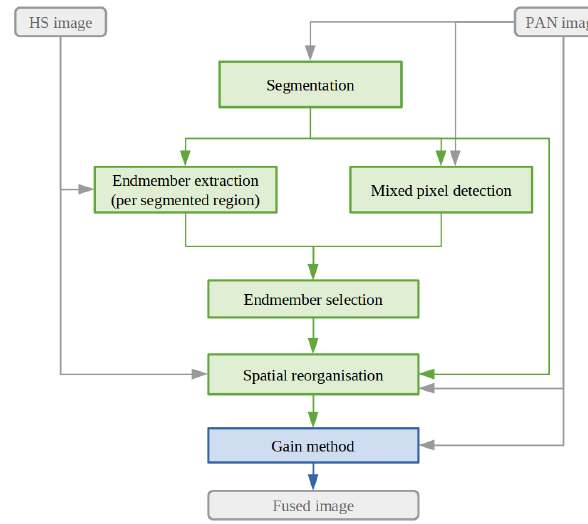
Figure 1. Flow chart of the SOSU method (the preprocessing steps are identified in green, the fusion step in blue) The presented method assumes the following